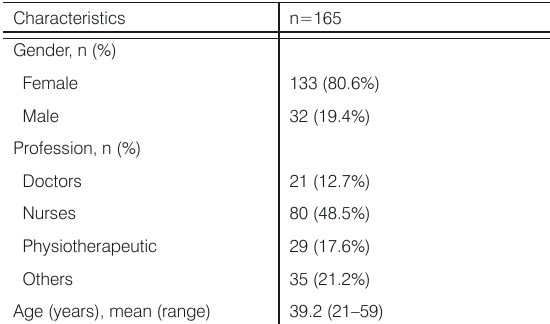
Table 1. Characteristics of